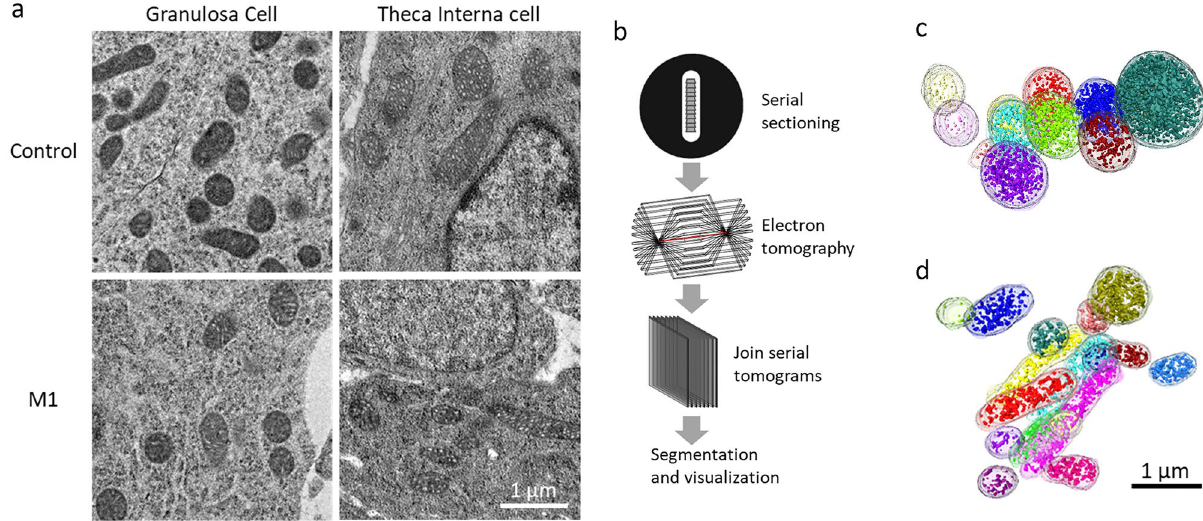
Figure 3. M1 injection did not change the mitochondrial network of the granulosa cells and theca cells in matured follicles. The samples were collected in the evening (20:00) of proestrus after the second M1 or control injections. The electron micrograph shows the rod- or globular-shaped mitochondria in both granulosa cells and theca cells ( a ). The flowchart for the visualizations of 3D mitochondrial networks ( b ). The 3D mitochondrial networks in control ( c ) and M1 ( d ) theca cells were reconstructed through the serial section and electron tomography. The mitochondrial cristae were labeled in opaque colors and the outer membranes were labeled in transparent colors. The mitochondria without physical connections were labeled with different colors. No obvious fusing or branch mitochondria were